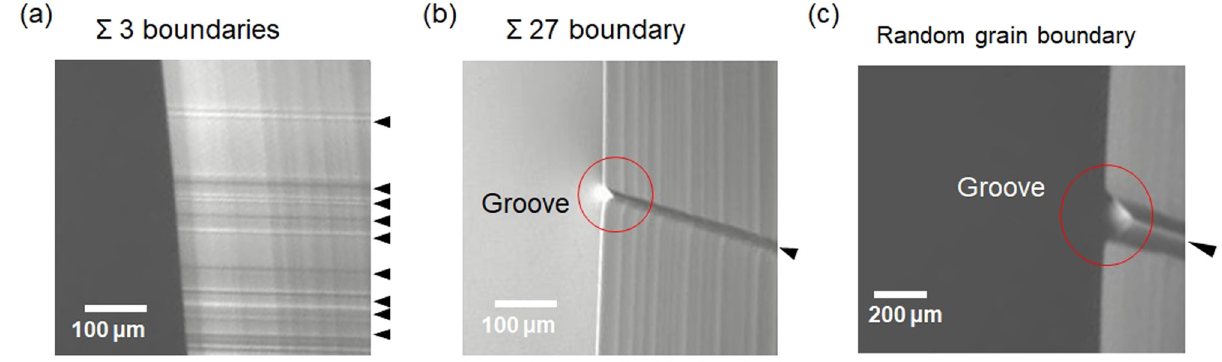
Figure 11: Shape of crystal/melt interfaces for various grain boundary characteristics [ 100 ] : ( a ) an interface with Σ 3 twin boundaries. A grain boundary groove is not observed, ( b ) an interface with a Σ 27 grain boundary. A faceted grain boundary groove is observed, and ( c ) an interface with a random grain boundary. A faceted groove is observed, similar to ( b ) .